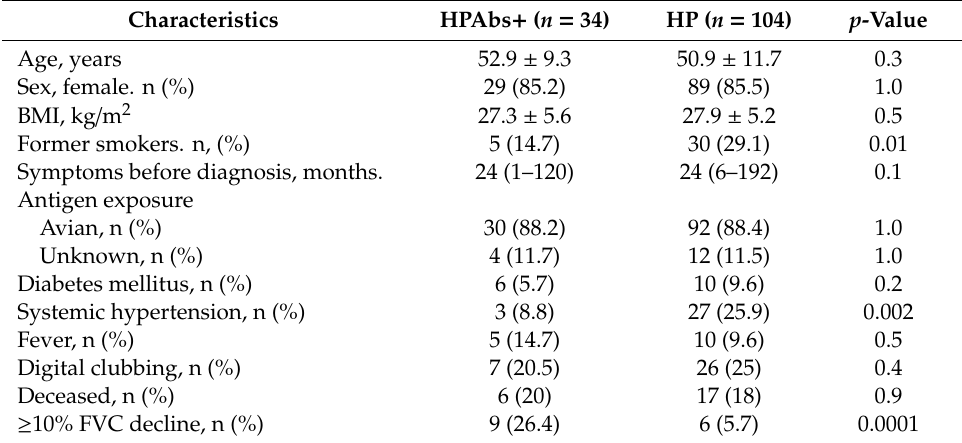
Table 2. Clinical and demographic